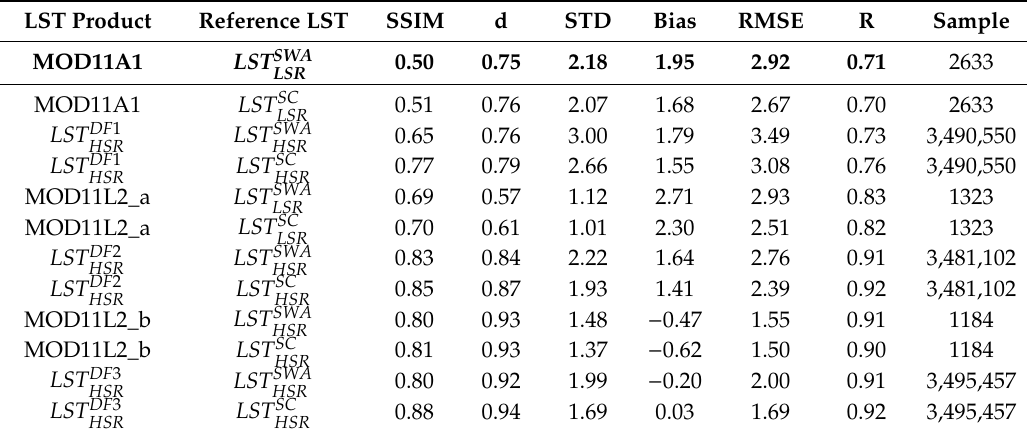
Table 2. The comparison results of the fused LSTs and MODIS LSTs with reference LSTs in Case 1.